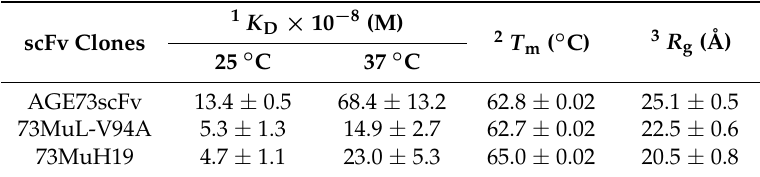
Table 1. Characterization of scFv clones.